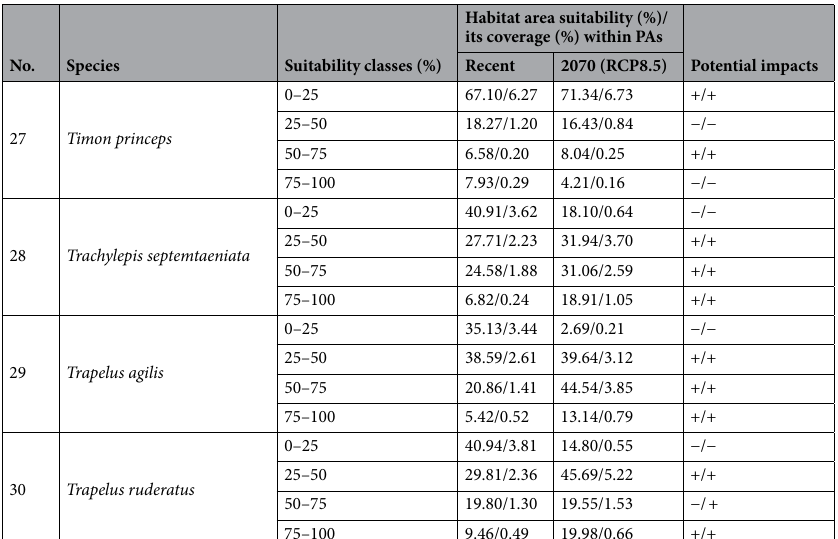
Table 4. The habitat area suitability (%) and its coverage (%) within the protected areas (PAs) network for the response of 30 lizard species to future (2070) climate change under a pessimistic (RCP8.5) scenario compared to recent climatic conditions. + denotes a positive impact; − denotes a negative